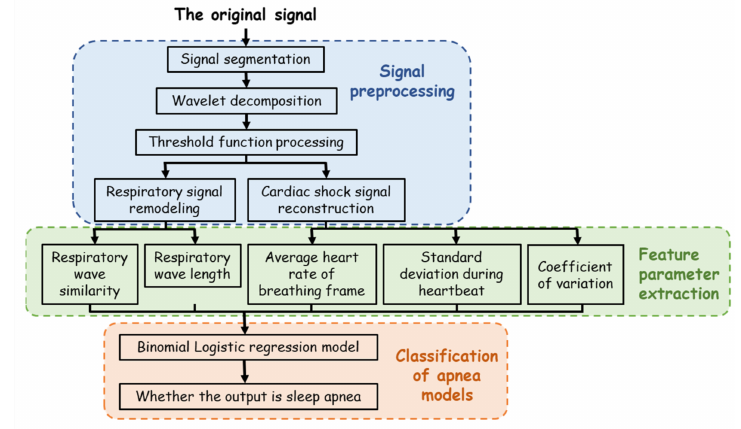
Figure 4. Signal processing algorithm process flow chart.